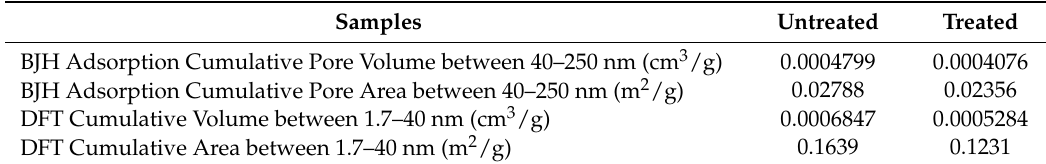
Table 7. Pore volume and specific area determined by argon adsorption.